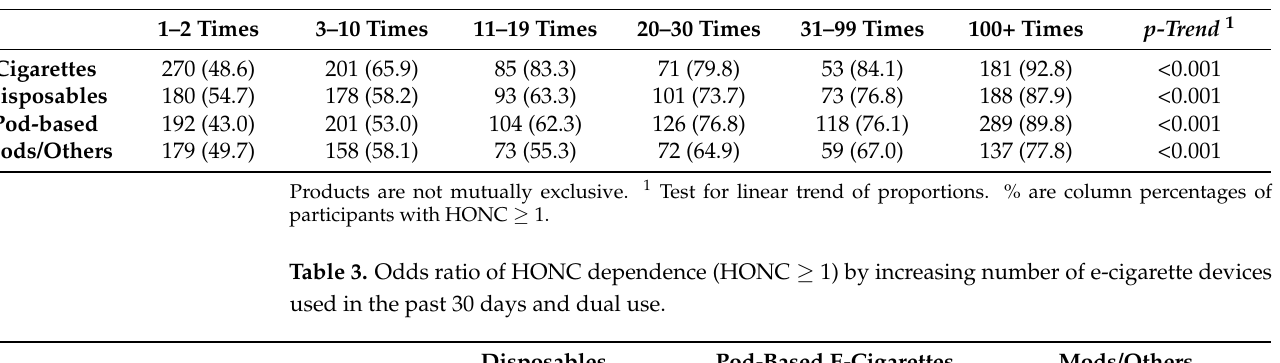
Table 2. Participants endorsing nicotine dependence (HONC ≥ 1), by number of lifetime uses ( n , %). Number of Lifetime Uses